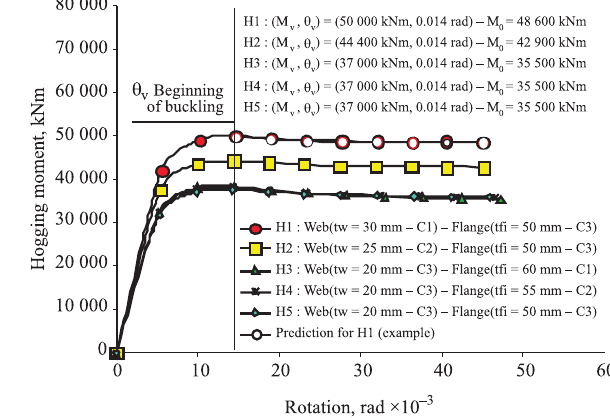
Fig. 11. 3D calculations and buckling curves – class 3